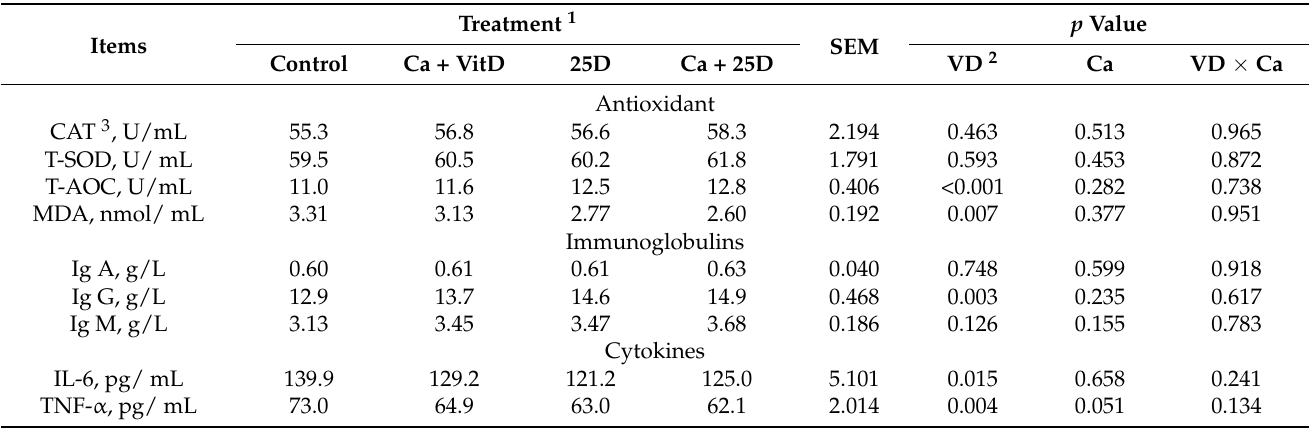
Table 5. Effect of 25-hydroxyvitamin D 3 and oral calcium bolus on antioxidant and immune function of postpartum Holstein